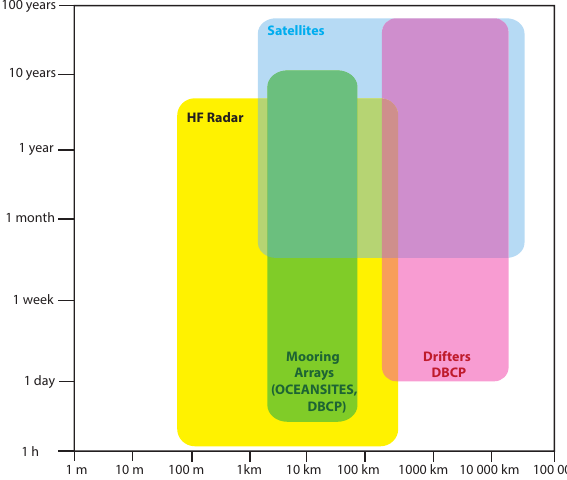
Figure 3. Spatio-temporal coverage by different technologies to measure sea surface currents. Adapted from the specifications sheet provided by the Global Ocean Observing System (GOOS), available at